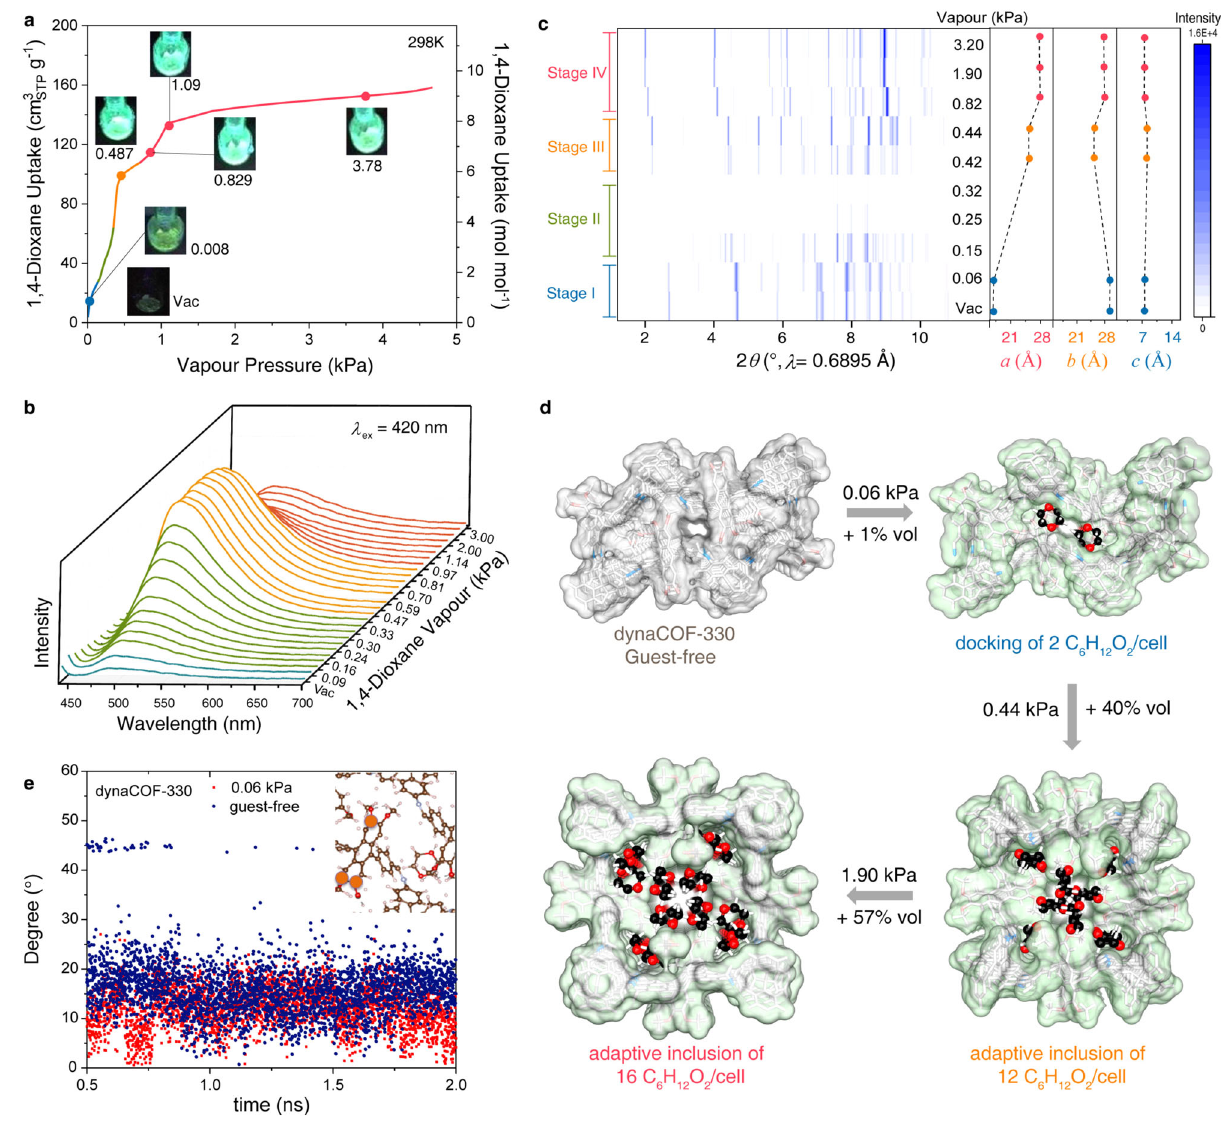
Fig. 4 | Anomalous fl uorescence response and structural transition of dynaCOF-330 upon adaptive docking and inclusion of 1,4-dioxane vapour. a OpticalimagesofdynaCOF-330under365-nmUVlightsshowingthe fl uorescence turn-onand intensity changesfor representative equilibrium pressures and uptake of 1,4-dioxane vapour at 298K. b Quantitative in-situ fl uorescencespectroscopy of dynaCOF-330 showing constant maxima of emission wavelength. c Lattice para- meters re fi ned from ex-situ PXRD of dynaCOF-330 at representative equilibrium